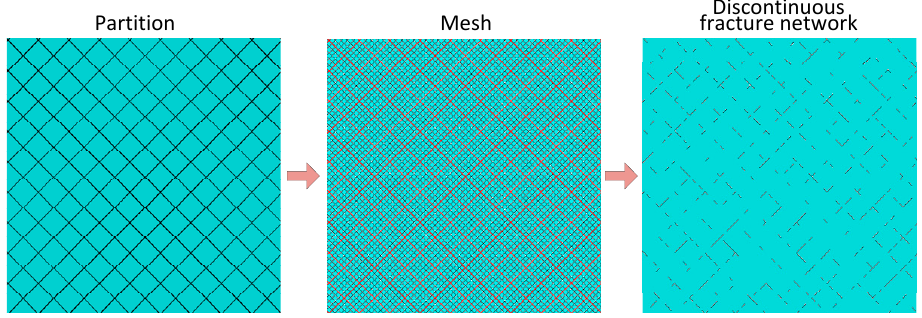
Figure 3. The process of creating the discontinuous fracture network.